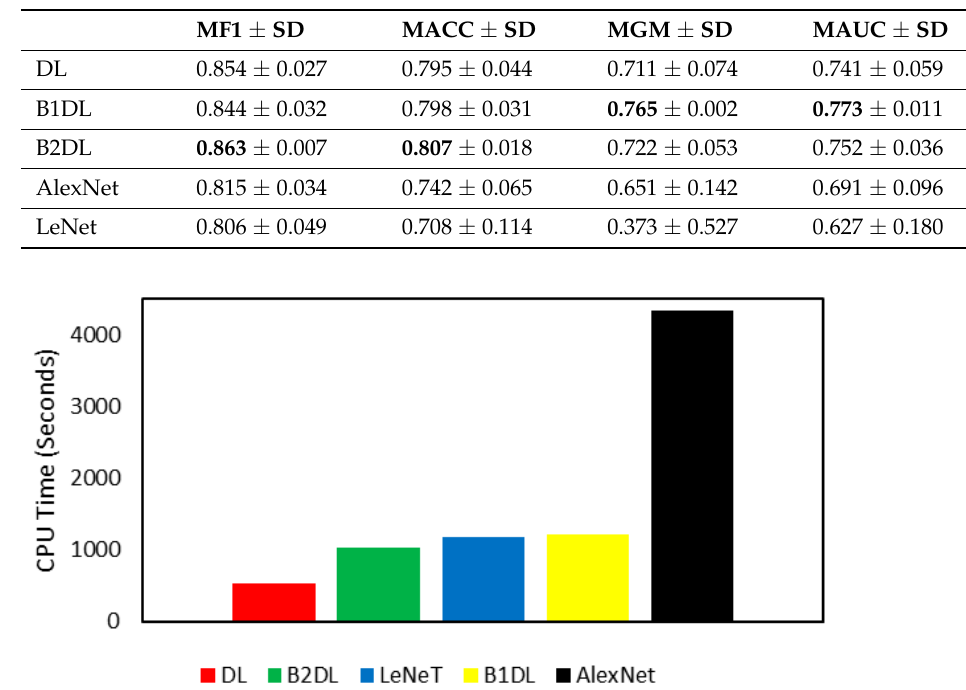
Figure 7. Comparison of the total running times (in seconds) of all predictions of the quality of in vitro bovine embryos. The prediction algorithm on the far left is the fastest, while the prediction algorithm on the far right is the slowest.